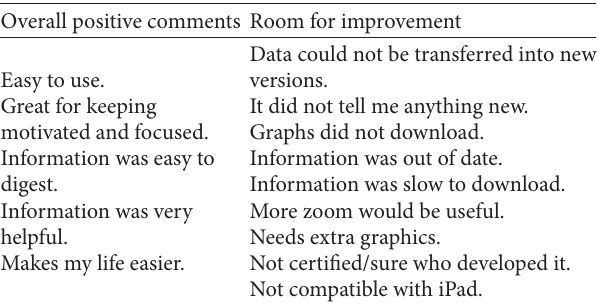
Table 3: Examples of commentaries from women’s health